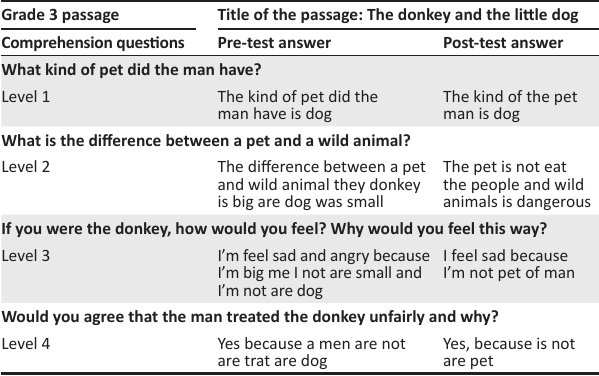
TABLE 2: L2’s written pre-test and post-test responses.